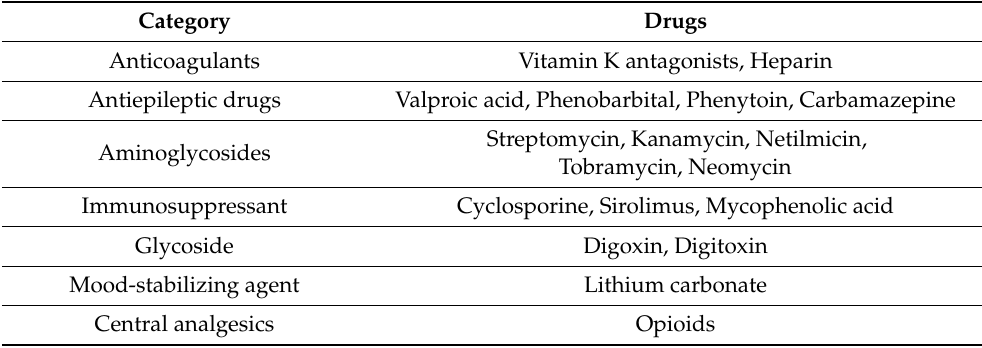
Table 2. Examples of drugs with narrow therapeutic